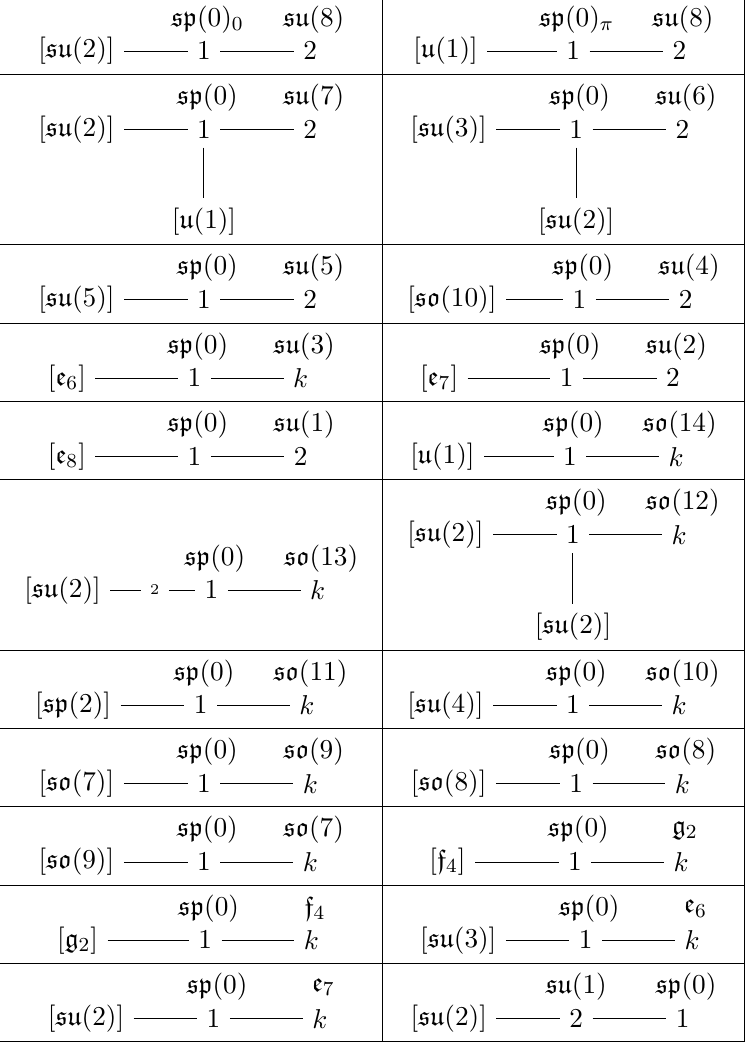
Table 3 . Possible localized flavor symmetries for nodes with a trivial gauge algebra. Continued in table